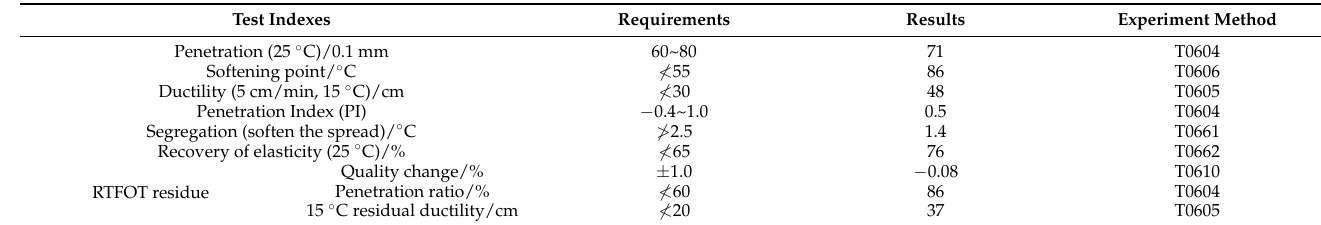
Table 1. Properties of SBS modified asphalt.